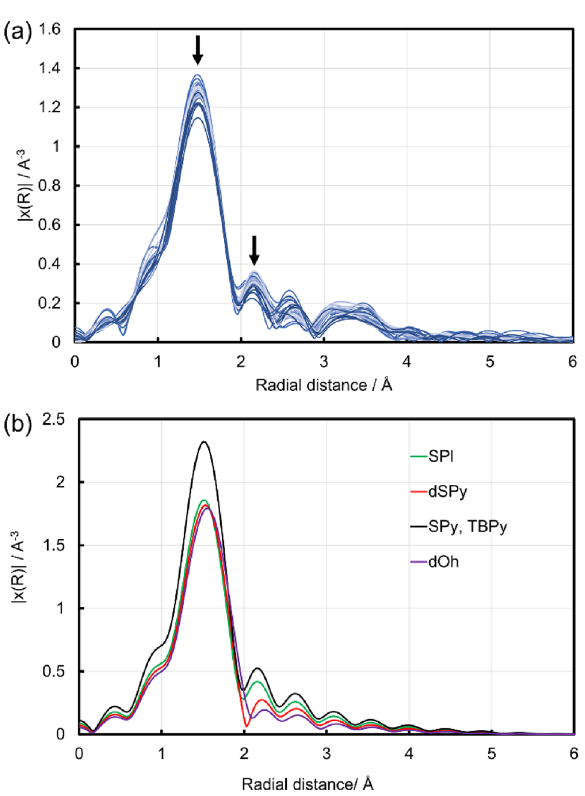
Figure 3. ( a ) Cu K-edge FT-EXAFS spectra for the twenty-eight Cu zeolites presented in Fig. 1. The two arrows indicate peaks at ca. 1.5 and 2.1 Å where the peak intensities are collected as structural variables of the Cu zeolites. ( b ) Simulated Cu K-edge FT-EXAFS spectra for four types of Cu local structures having 4–6 coordinated oxygen atoms as models of hydrated Cu 2+ with dOh, dSPy, SPy, TBPy and SPl